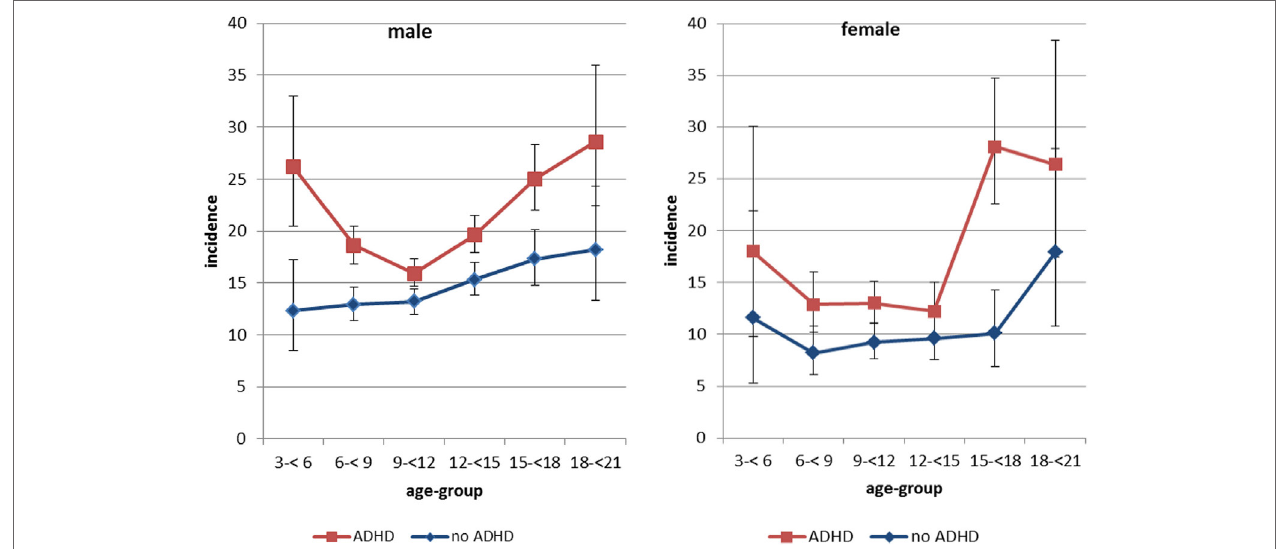
FigUre 1 | Incidence of hospitalizations with at least one injury diagnosis by ADHD status, age-group, and sex*. *Per 1,000 person-years. Note: Whiskers represent 95% confidence